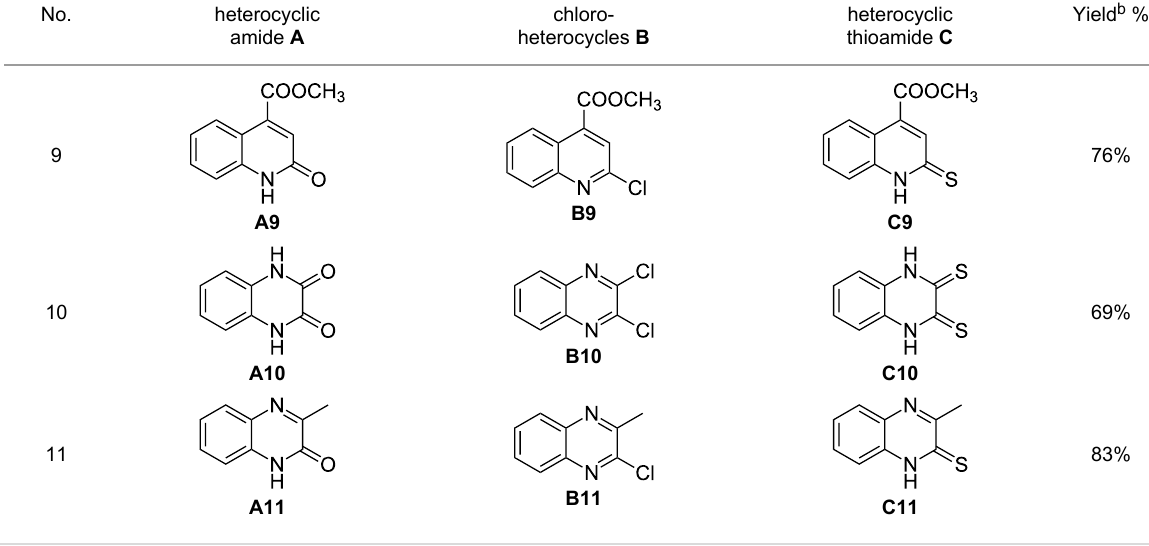
Table 3: Synthesis of quinolin-2-thiones C9 and quinoxalin-2-thiones C10–C13 a .